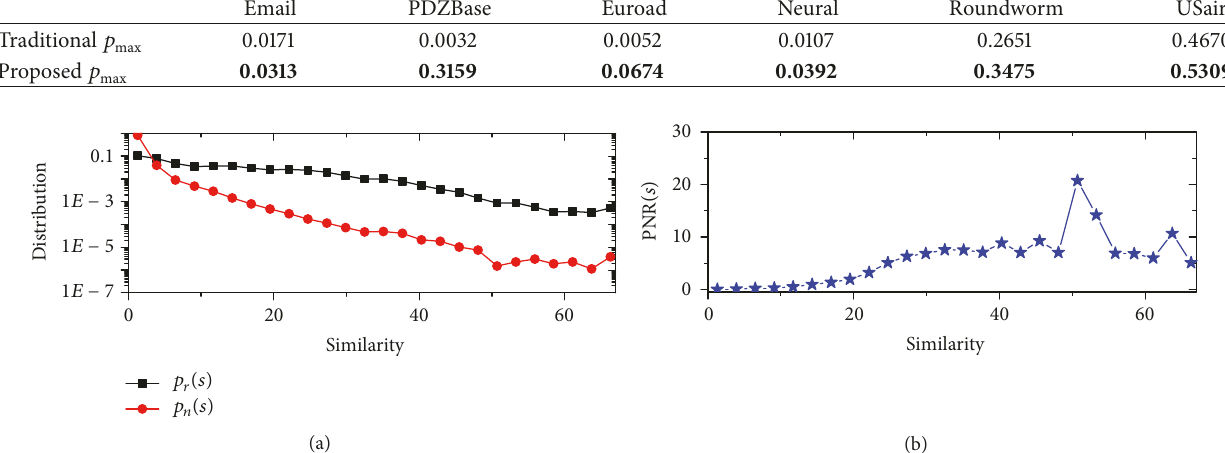
Figure 3: Similarity distributions and the corresponding PNR (𝑠) of USair network, where the similarity is obtained by CN method. (a) Similarity distributions of the existing and nonexisting links, 𝑝 𝑟 (𝑠) and 𝑝 𝑛 (𝑠) , respectively. (b) PNR (𝑠) as a function of similarity in USair network.